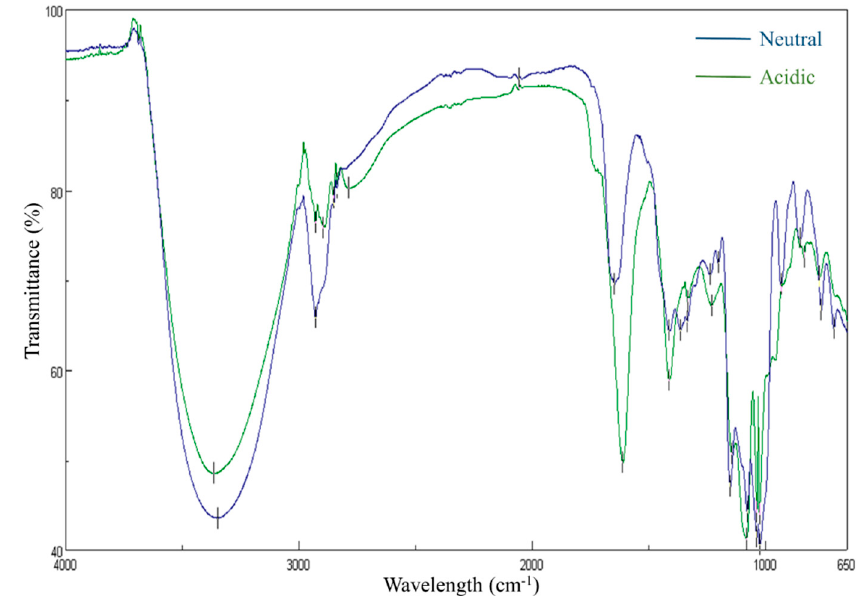
Figure 2. The FT-IR spectrum of WGNP (Neutral) and WGAP (Acidic).